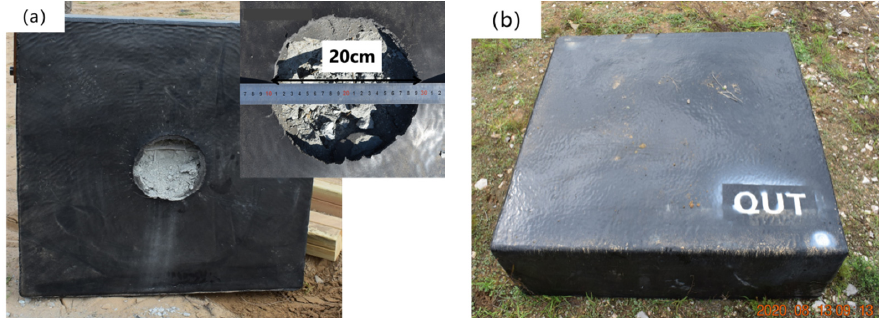
Figure 13. Failure modes of coated reinforced concrete slab after explosion with explosion distance of 50 mm: ( a ) blast face surface; ( b ) back blast surface. The T26 polyurea coating after explosion damage was divided into section area I, explosion source center area II, and coating edge area III, and the coatings in the three regions were cut for microscopic morphology observation, as shown in Figure 14.